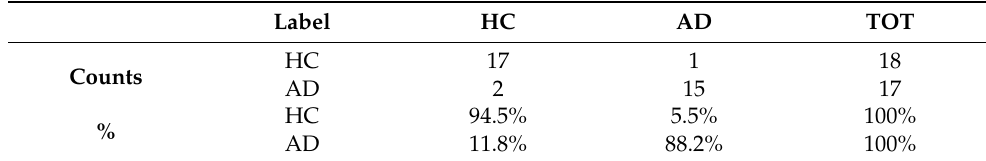
Figure 7. Cross-validation (CV) classification outcome of the multivariate data-driven analysis predicting AD and HC from the 6 NC metrics. ( a ) Receiver operating characteristic (ROC) analysis. ( b ) Upper panel: model loadings; lower panel: z-scores obtained as loadings normalized by a bootstrap estimate of their standard deviation. Table 2. Confusion matrix obtained by selecting a specific threshold of the output of the multivariate linear regression classifying AD and HC from the 6 NC metrics.